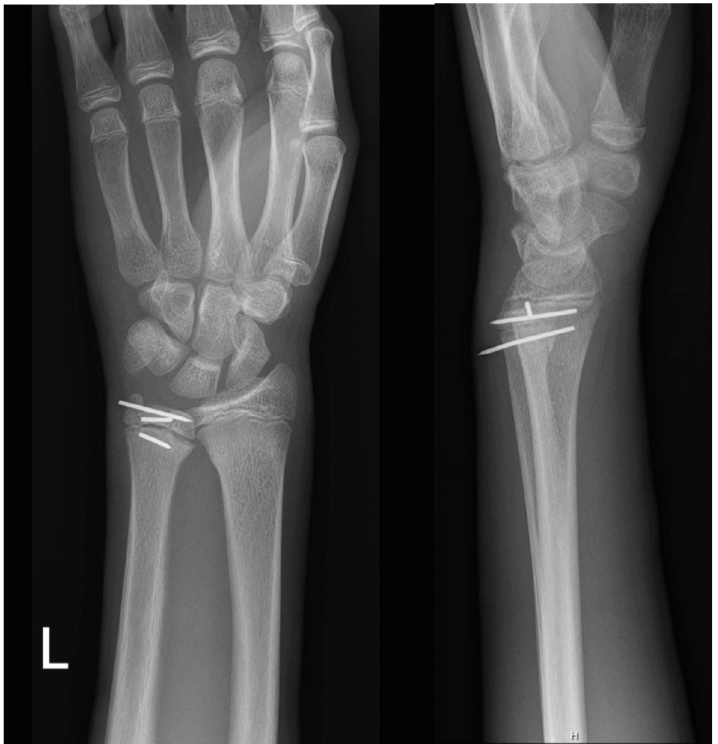
Figure 3: Anteroposterior and lateral X-ray 2 weeks after surgery.